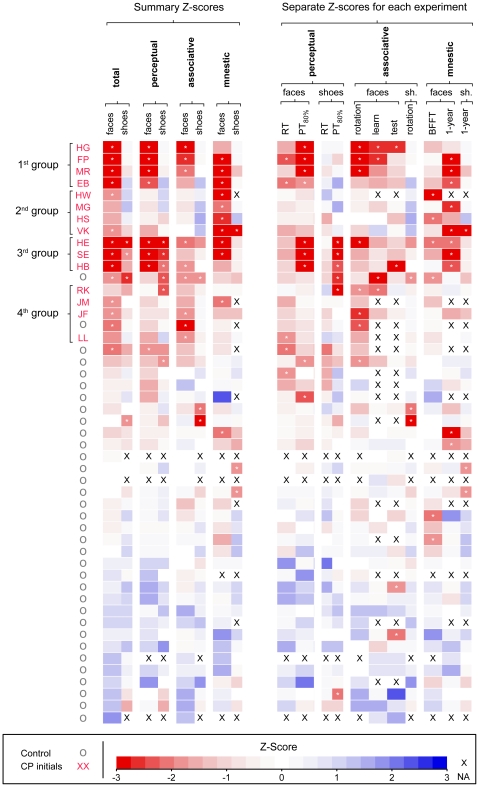
Overview of standardized test performance.Clustering participants according to their standardized test performance distinguishes CPs (top rows, marked by initials) from controls (bottom rows, marked by small circles) and reveals a dissociation of the deficits in CP into three homogeneous subtypes. In the table individual z-scores (color code at the bottom) are displayed for all of the tests (columns) based on estimated residuals for each participant. Significant deficits (modified t-test, 5% cutoff) are marked by an asterisk, missing values are denoted by X. Columns on the left side (Summary Z-scores) display aggregate performance across all or several tests, columns on on the right side display performance in individual tests (Separate Z-scores). Rows are ordered according to an unsupervised clustering on aggregate test results (complete linkage analysis). Abbreviations: RT = reaction time, PT80% = presentation time needed for 80% correct performance, BFFT = Bielefeld famous face test.